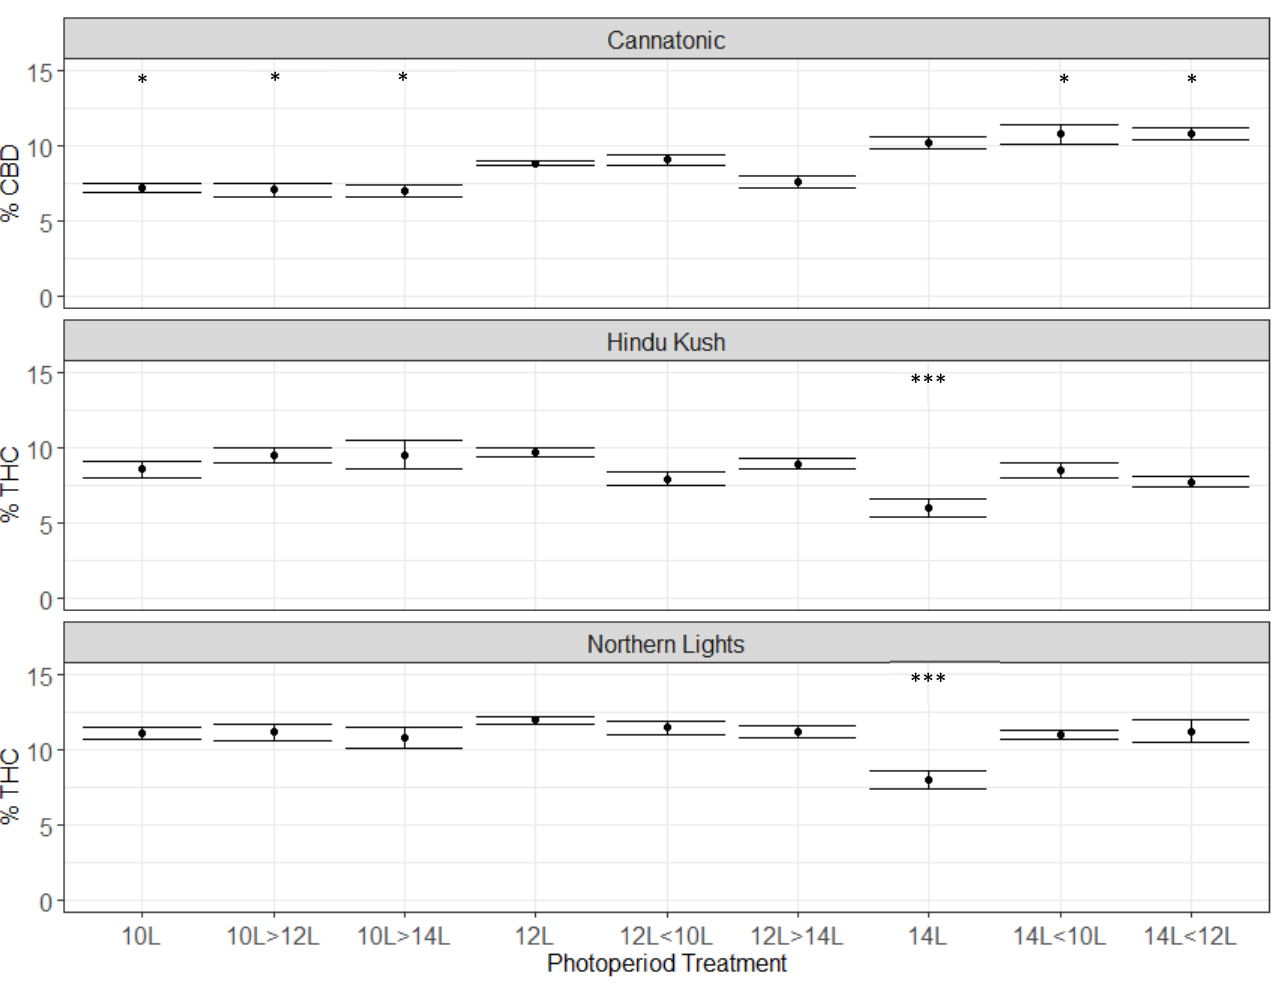
Figure 3. Cannabinoid data from the three genotypes: Cannatonic, Northern Lights, and Hindu Kush. Asterisks above the error bars indicate that the treatment was significantly different to the control 12L treatment, Dunnet’s test, *** p ≤ 0.001, * p ≤ 0.05, N = 4 − 5 +/ − SE. The relationship between biomass yield and cannabinoid concentration for the three static treatments (10L, 12L, and 14L) is shown in Figure 4. However, the critical point at which flower biomass started to decline was not identified by this study as, in all lines, the DW yield increased between 12 and 14L. These data also suggested that the optimal photoperiod for yield in Cannatonic may be longer than 14L as both the biomass and can- nabinoid concentration continued to increase up to 14L (Figure 4).